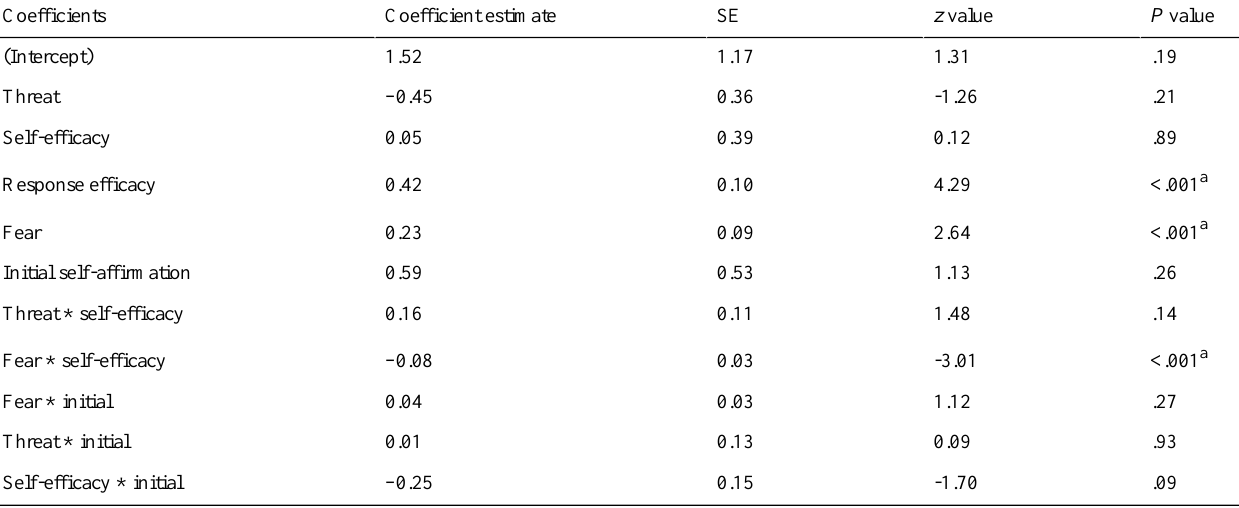
Table 3. Coefficients for the extended parallel process model linear regression